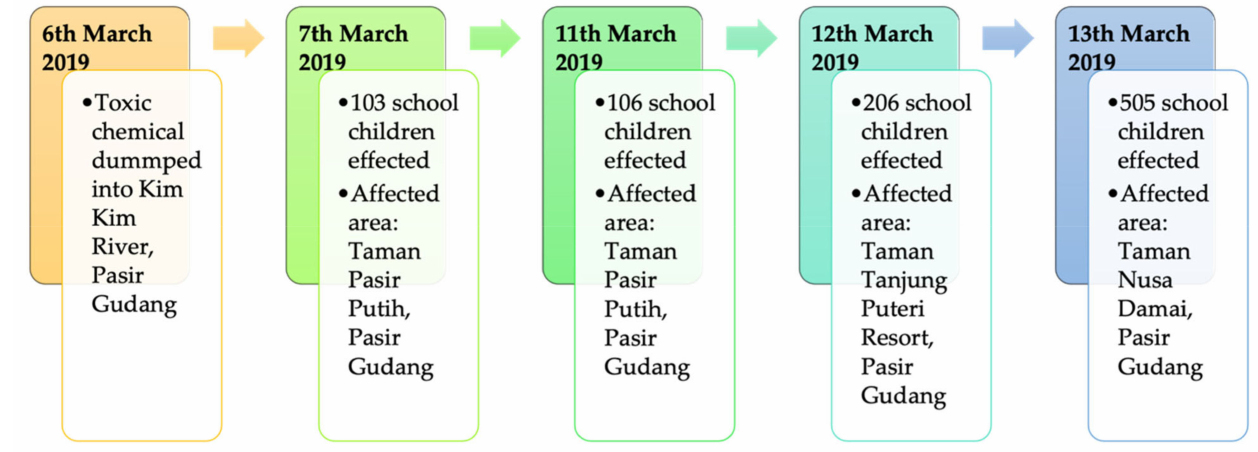
Figure 3. Chronology of chemical pollution in Kim Kim River, Pasir